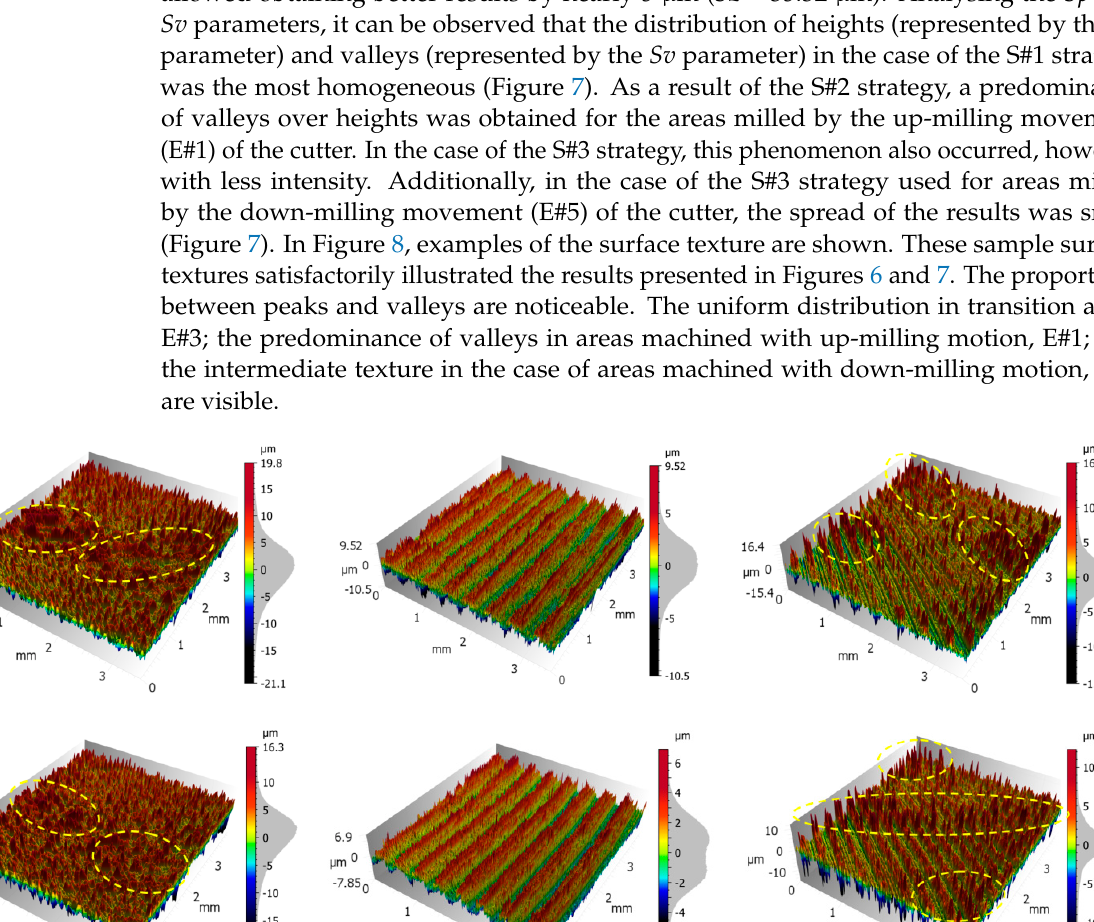
Figure 7. Centre and spread of Sz, Sp and Sv parameters for three milling strategies: S#1 ( a ), S#2 ( b ) and S#3 ( c ). The box plot presents the mean, the median, the interquartile range box and the range